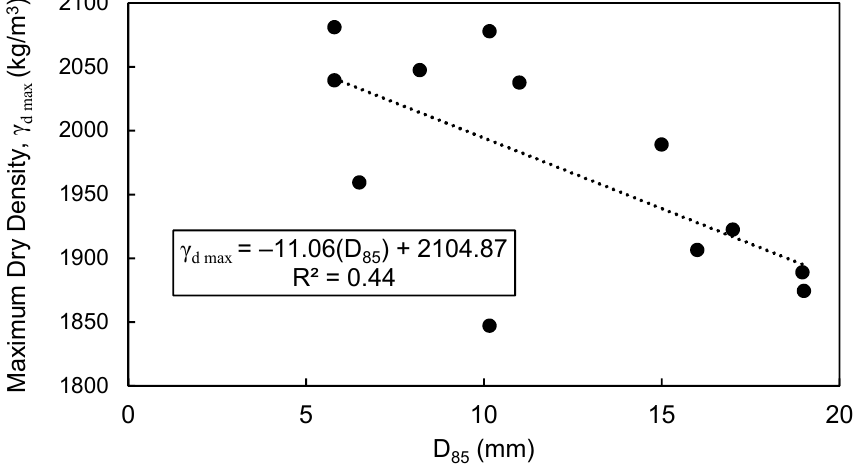
Figure 5. Maximum dry density (MDD) versus D 85 for RAP from the literature [12,15– Figure 5. Maximumdrydensity(MDD)versusD 85 17,19,27,31,32,34,36,38,44].